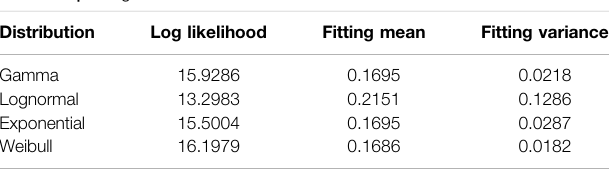
TABLE 6 | Fitting effect evaluation.